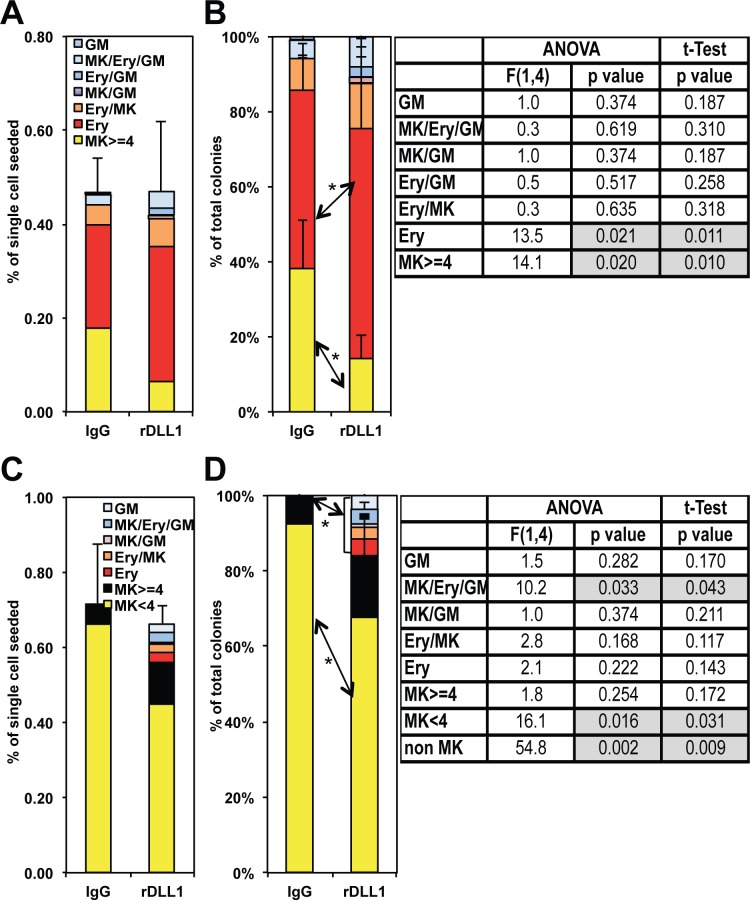
Single cell progeny analyses of CD9Med and CD9High MEPs with or without Notch activation.Single CD9Med or CD9High MEP were individually seeded in 96 wells culture plates that have been coated with either IgGs or rDLL1 and containing medium supplemented with a complete cocktail of myeloid cytokines. The different types of developed colonies were numbered at day 7 by visual inspection under bright light microscope as illustrated in S8 Fig. A, B: Repartition of the indicated type of colony as a percentage of all single seeded CD9Med MEP (A) and as a percentage of CD9Med MEP raising colonies (B) (Means and standard deviations from 3 independent experiments). C, D: Repartition of the indicated type of colony as a percentage of all single seeded CD9High MEP (C) and as a percentage of CD9High MEP raising colonies (D) (Means and standard deviations from 3 independent experiments). Tables on the right display p-values in Tukey’s test post ANOVA and in Student t-test analyses of the variations in the proportions of different types of colonies between IgG and rDLL1 conditions. Statistically significant variations are indicated by grey boxes in Tables and by asterisks on right histograms.